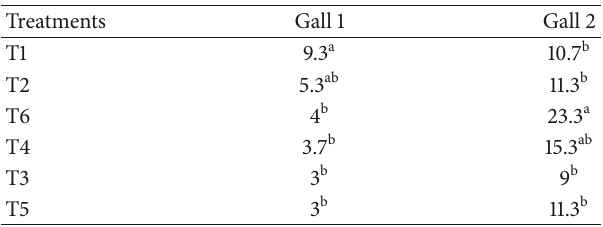
Table 2: Means of chilli gall